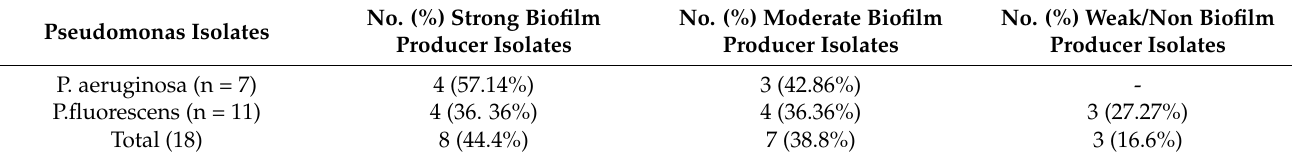
Table 2. ELISA assay of biofilm formation among isolates of Pseudomonas